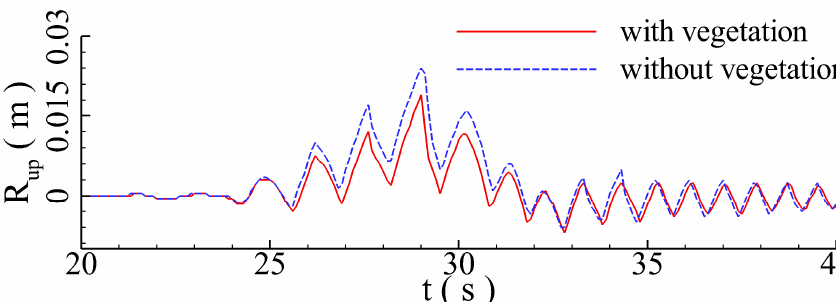
Figure 12. Time series of the wave runup height.